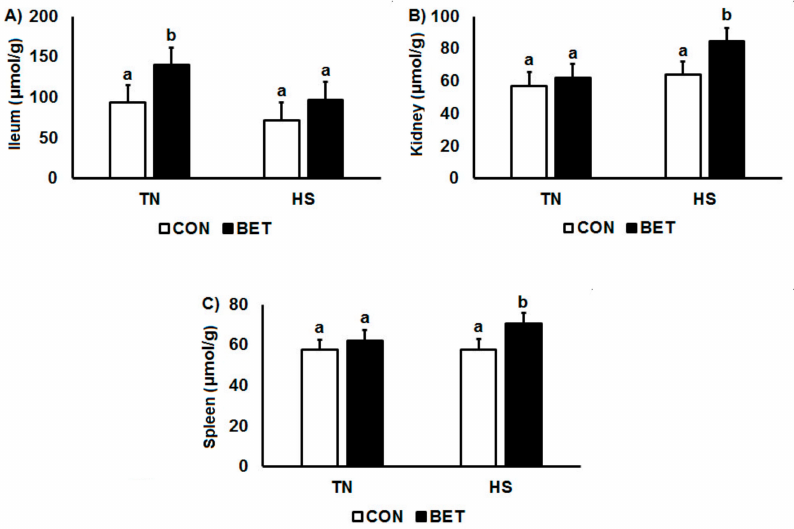
Figure 7. Changes in the distribution of betaine: ( A ) ileum, ( B ) kidney, and ( C ) spleen in broilers during thermoneutral (TN) vs. heat stress (HS) environmental challenge. Broilers were fed either a control diet (CON) or betaine diet (BET), and the mean represents the main e ff ect of 5 time points (1, 2, 3, 7 and 10 day challenge). Means with di ff ering superscripts denote p < 0.05. Refer to Table 3 for full interactive e ff